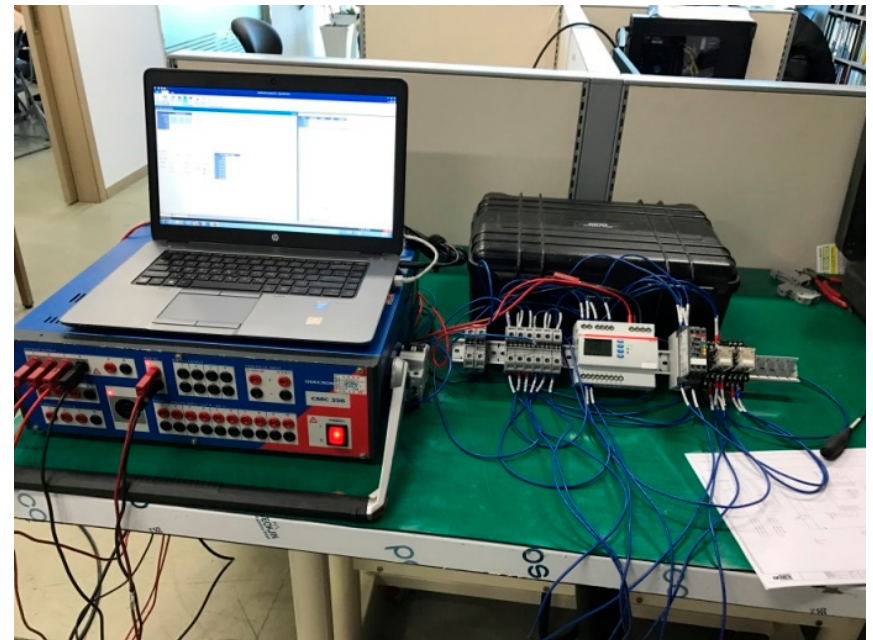
Figure 26. Relay testing.